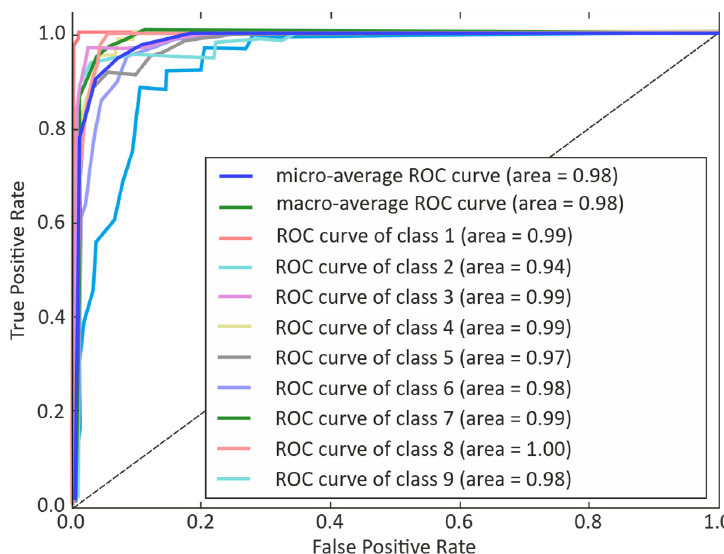
Figure 4. ROC plot for RF classifier (micro-averaged 98%).